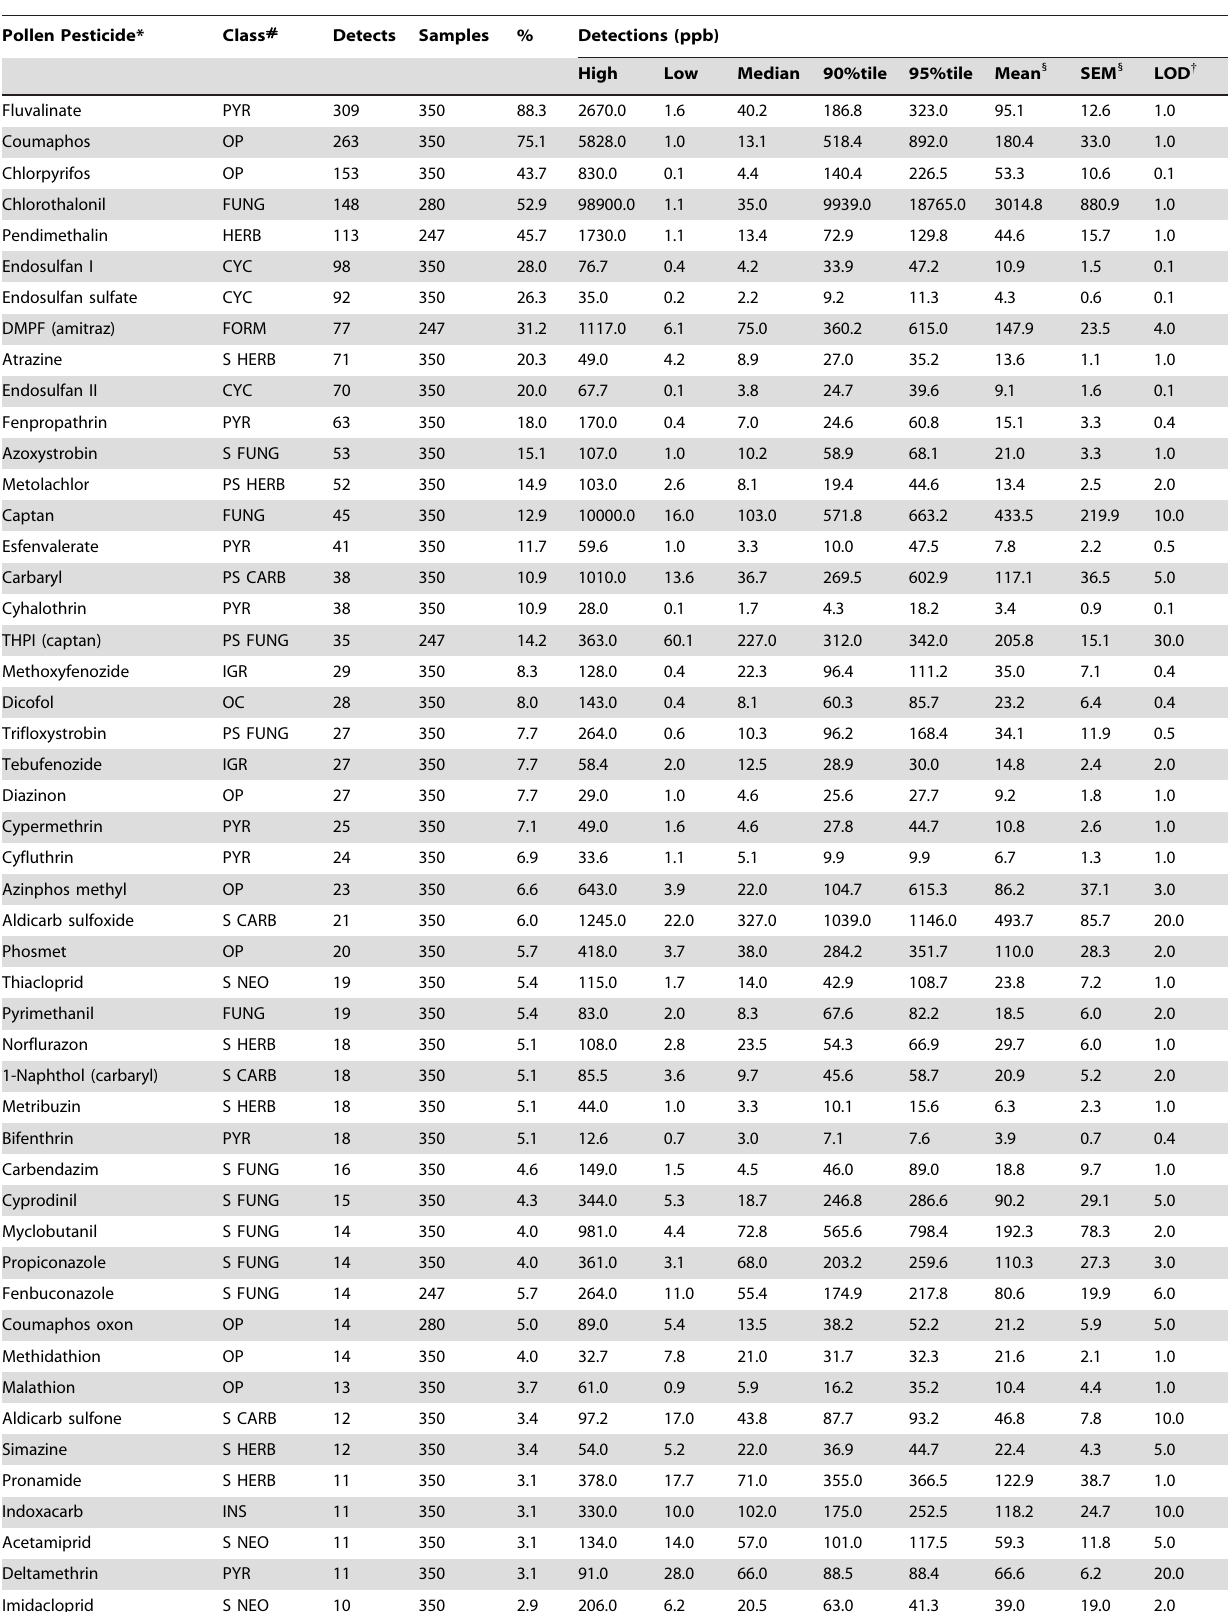
Table 2. Summary of pesticide detections in pollen samples from North American honey bee colonies.